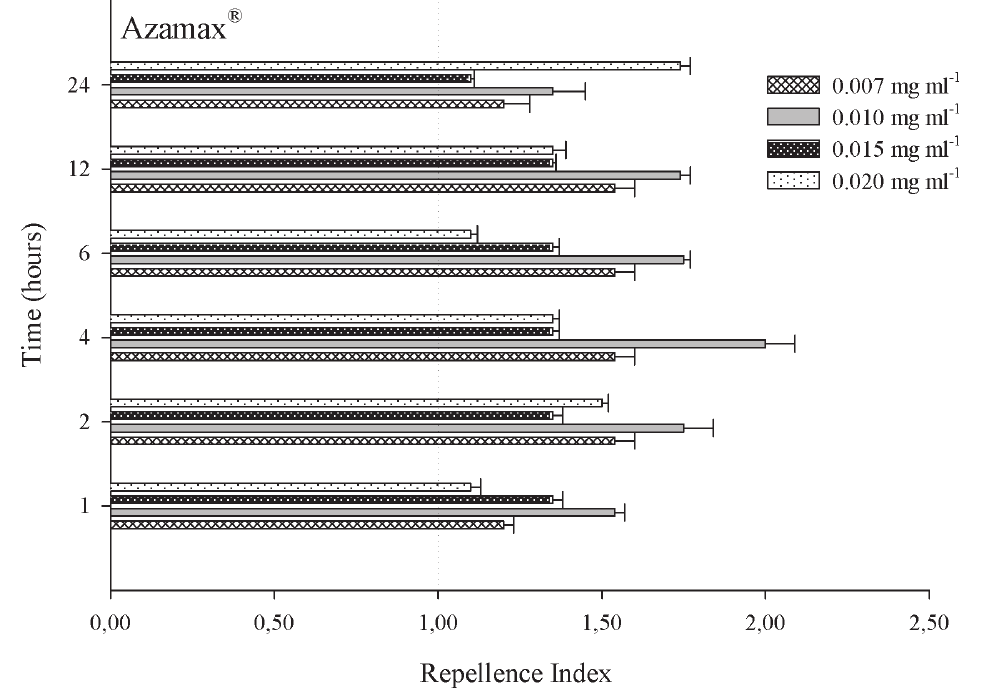
Figure 3. P. xylostella larval repellency after exposure to plant-based insecticide Azadirachtin for 24 h. Table IV. Percentage of injury (phytotoxicity) promoted by Piper essential oils on collard greens leaf discs . Essential oils Positive